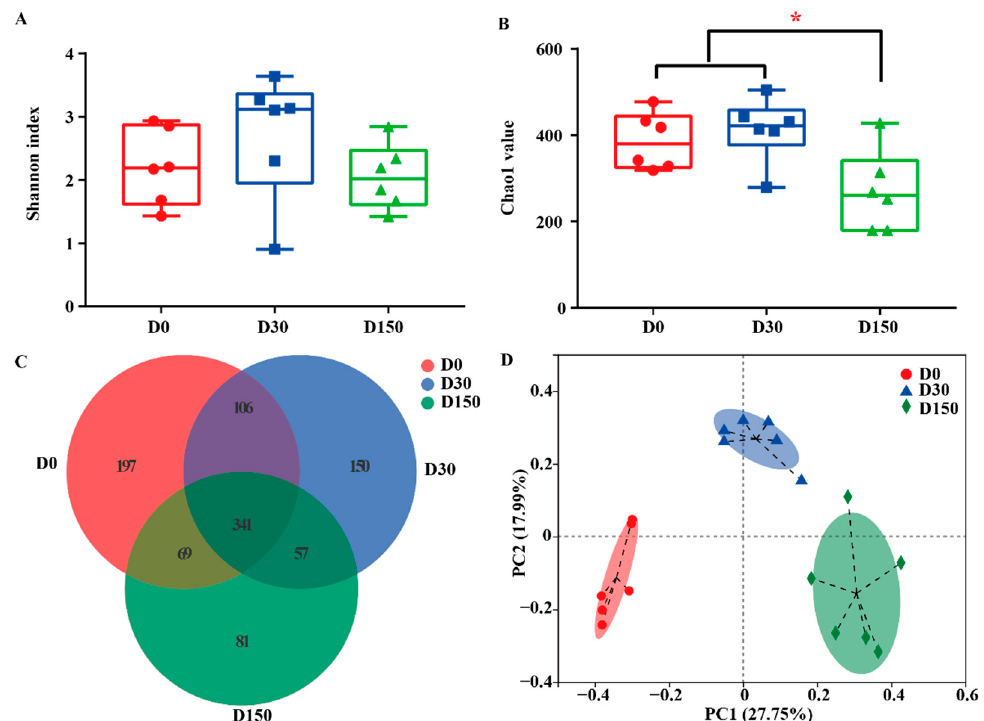
Figure 2. Fungal diversity across the three storage times (n = 6). ( A ) Fungal diversity was estimated by the Shannon index. ( B ) Fungal richness is estimated by the Chao1 value. ( C ) Venn diagram representing the common and unique OTUs found at each storage time point from the three groups. ( D ) Principal coordinate analysis (PCoA) of samples was conducted based on weighted UniFrac distance from the three groups. D0, storage for 0 d; D30, storage for 30 d; D150, storage for 150 d. * Indicates significant difference among the three groups at p < 0.05 level.